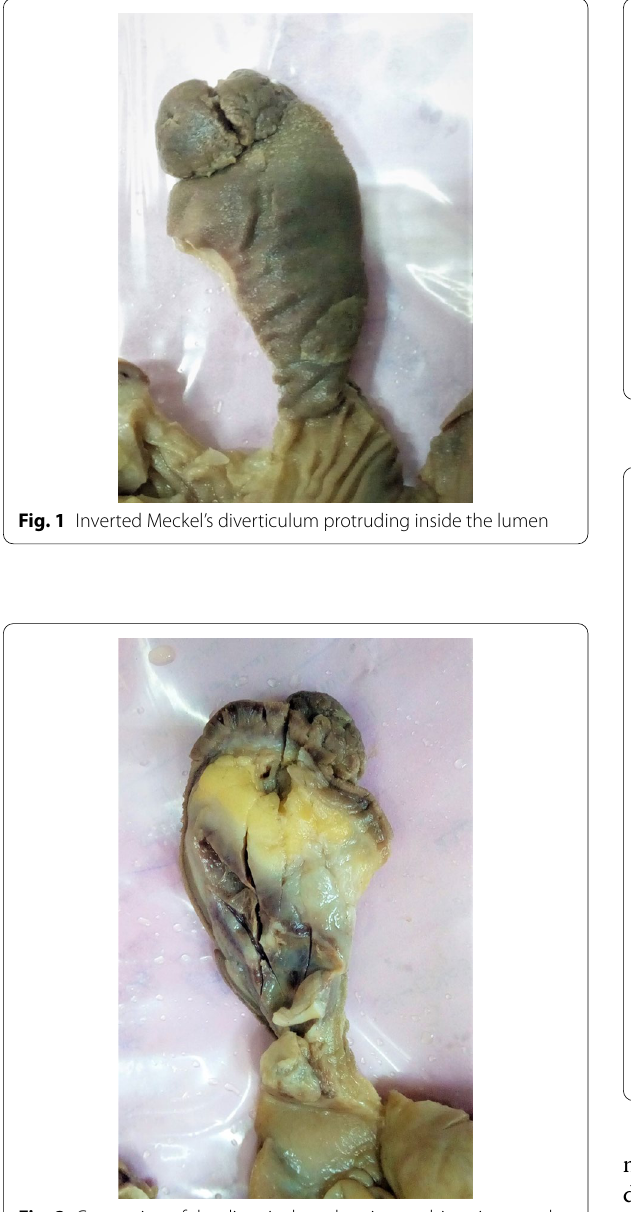
Fig. 2 Cut section of the diverticulum showing avulsion site near the tip representing the ectopic pancreatic tissue